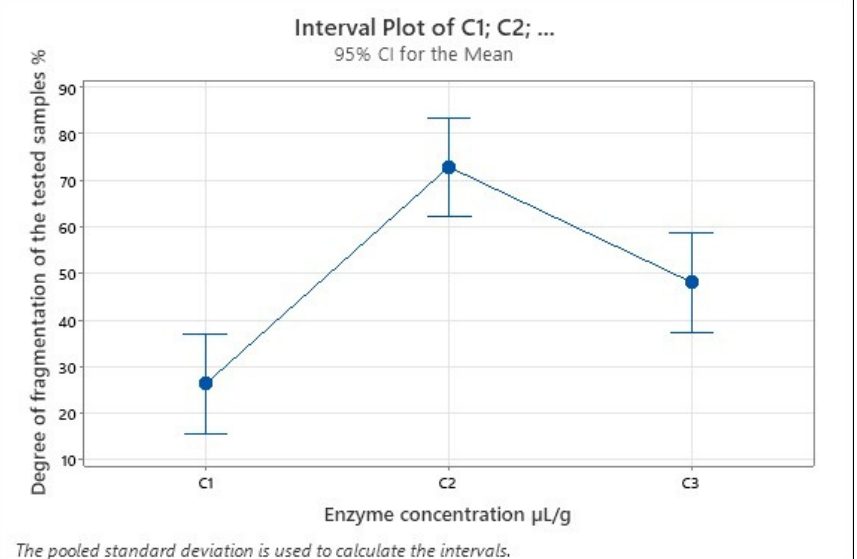
Figure 2. Degree of fragmentation for each concentration when the other parameters change (temperature and time).